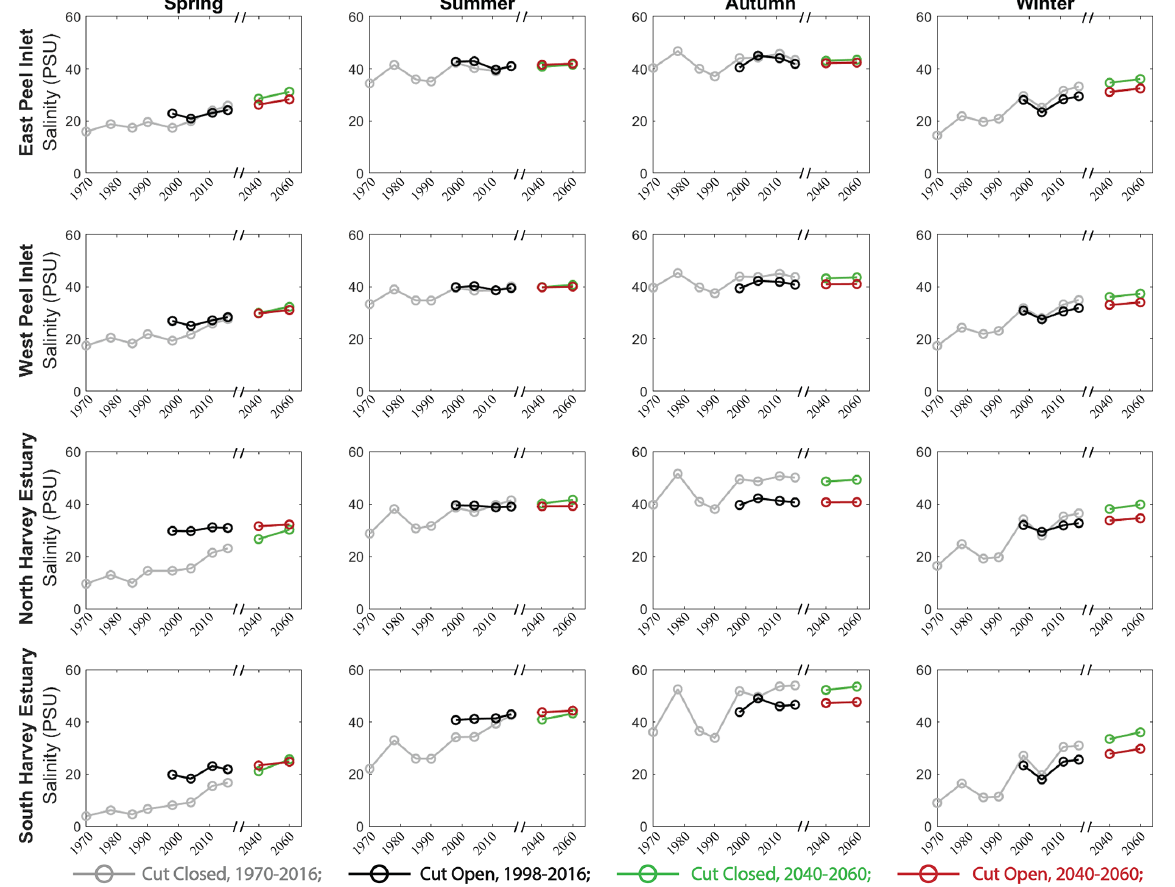
Figure 10. Changes of mean salinity in PHE in simulated years and future scenarios. As for Fig. 8, the changes are categorized into four zones and four